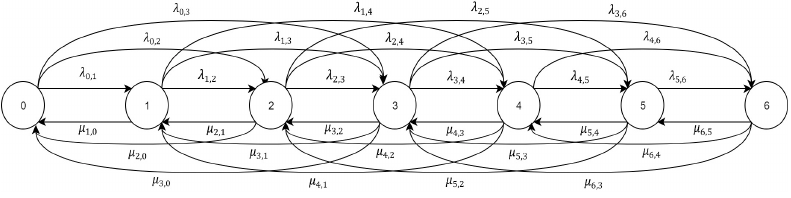
Figure 3. Markov chain for 𝑄 = 6,𝐴 = 3,𝑆 = 3 .